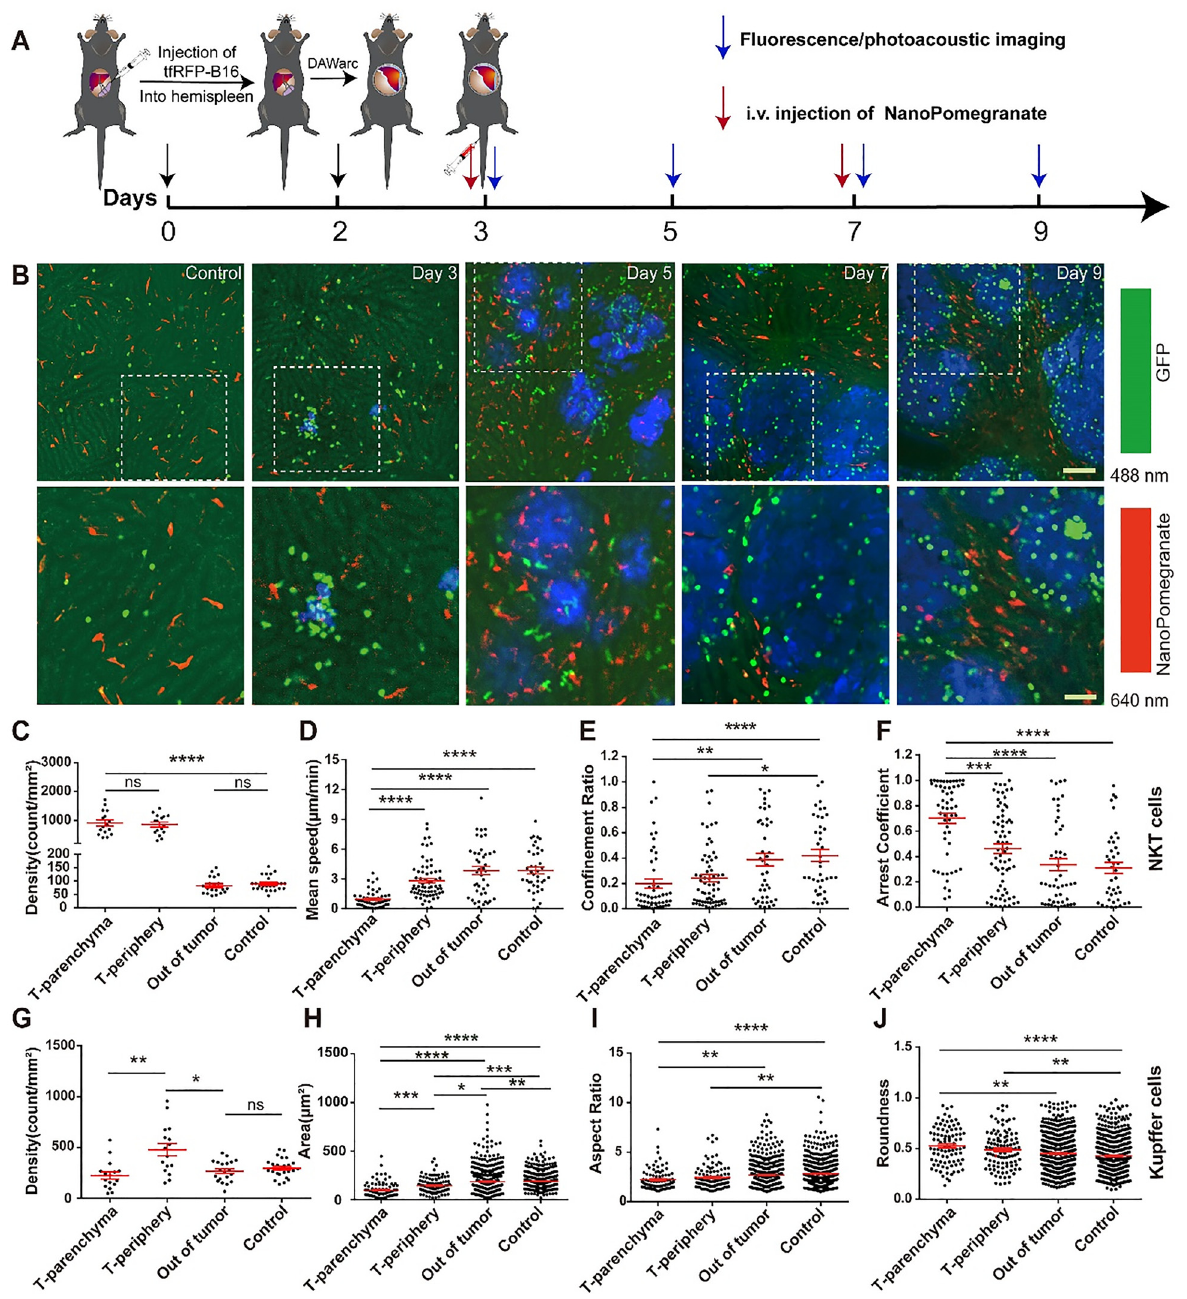
Figure 3: Long-term intravital fluorescence confocal imaging of liver metastases. (A) Schematics of the procedures and timeline of tfRFP-B16 cell injection, DAW implantation surgery, and long-term fl uorescence confocal imaging of liver tfRFP-B16 metastases. (B) Intravital fl uorescence confocal imaging of liver metastasis microenvironments at different times. Blue:tfRFP-B16tumormetastases;Green:GFP-labelediNKTcells;Red:nanopomegranatelabeledKupffercells(KCs).Toprow:2 × 2large- fi eld images;scale bar:100µm.Bottomrow:imagesof theregionsof interestfrom thetoprow;scalebar:50 µm.(C) ThedensityofiNKT cellsinthe tumor parenchyma, periphery, out-tumor regions, and control group on Day 5. The data are presented as the mean ± SEM ( n = 17 – 25 fi elds). (D – F) Scatter plots of the mean velocity (D), con fi nement ratio (E), and arrest coef fi cient (F) of iNKT cells in the tumor parenchyma, periphery, out-tumor regions, and control group. Each data point represents a single cell, and the red bars indicate mean values. * P < 0.05, ** P < 0.01, *** P < 0.001, **** P < 0.0001, ns: not signi fi cant. (G) The density of Kupffer cells (KCs) in the tumor parenchyma, periphery,out-tumor regions, and control group. The data are presented as the mean ± SEM ( n = 17 – 25 fi elds). (H – J) Scatter plots of the cell area (H), aspect ratio (I), and roundness (J) of KCs in the tumor parenchyma, periphery, out-tumor regions, and control group. Each data point represents a single cell, and the red bars indicate mean values. * P < 0.05, ** P < 0.01, *** P < 0.001, **** P < 0.0001, ns: not signi fi